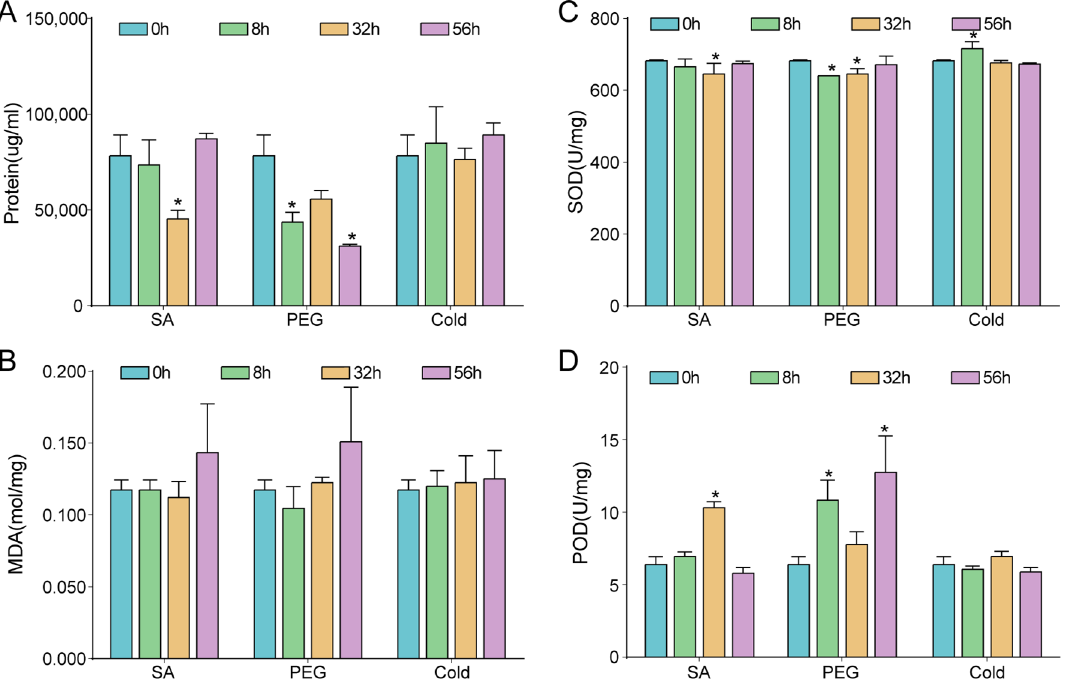
Figure 1. Physiological trait measurements after PEG, SA, and low-temperature treatment for 0 h, 8 h, 32 h, and 56 h in C. lanceolata . ( A ) the amount of soluble protein content in different treatments; ( B ) the amount of MDA content in different treatments; ( C ) the amount of SOD activity in different treatments; ( D ) the amount of POD activity in different treatments. (*, p < 0.05, t -test)